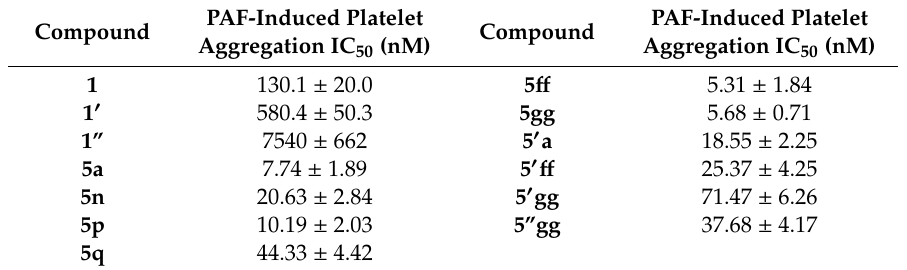
Table 3. In vitro antiplatelet aggregation activity study of some of ginkgolide-1,2,3-triazole derivatives.